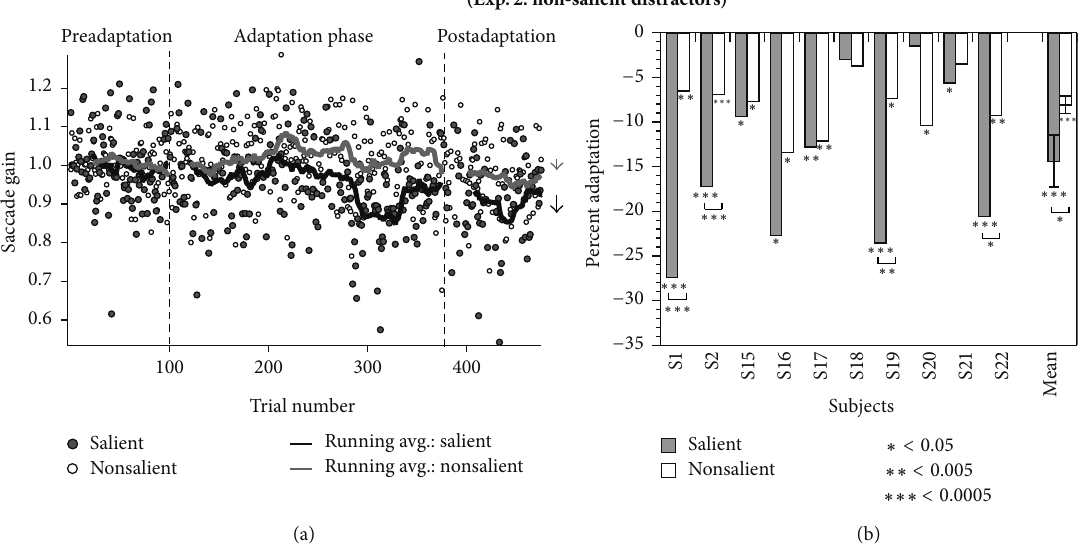
Figure 3: (a) Saccade gain data of subject S2 during Experiment 2 in which distractors consisted of a random noise patch (nonsalient) in Experiment 2(a) and salient images in Experiment 2(b). Gain decreased gradually in the presence of the random noise distractor (Experiment 2(a), open circles, grey curves) and displayed a significant decrease in gain of the postadaptation phase from the preadaptation phase. The salient distractors decreased gain even more rapidly and demonstrated a significant change (Experiment 2(b), closed circles, black curves). (b) Percentage adaptation (calculated as the difference between the pre- and postadaptation phases relative to the percent distance of the distractor from the target) for each subject. Mean and standard error across all subjects are shown on the right. The asterisks below each bar represent significance between the pre- and postadaptation phase in an individual experiment. The asterisks below a bracket represent the significance between the adaptation in the salient distractor and nonsalient distractor